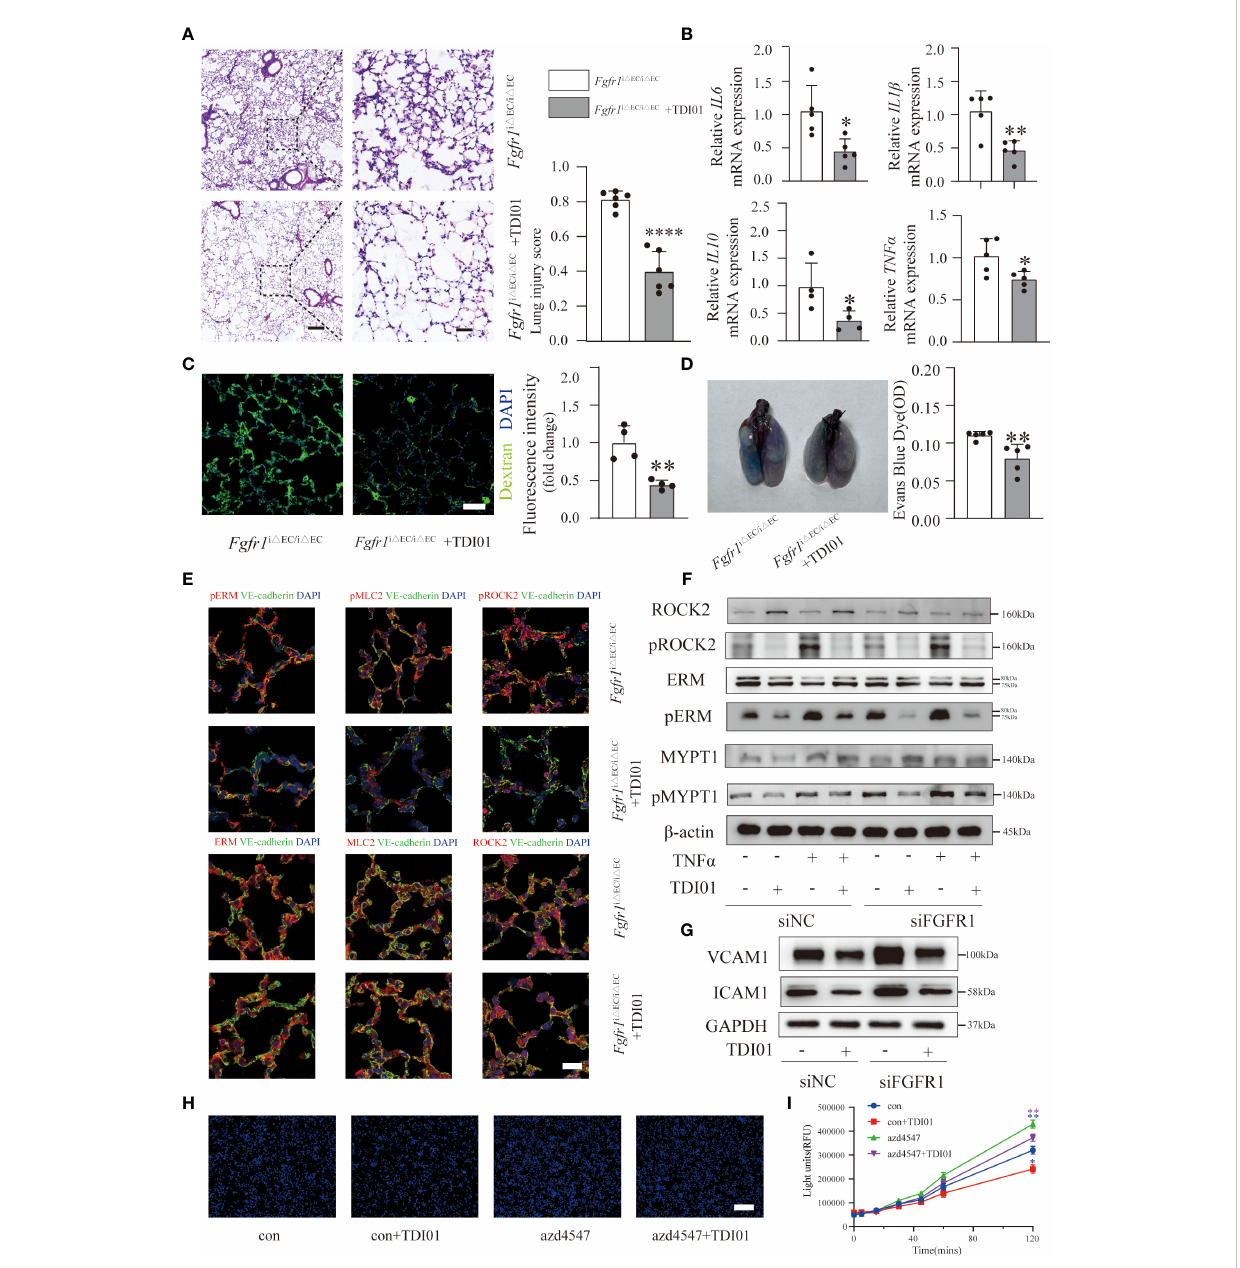
FIGURE 5 TDI01 effectively attenuated ALI/ARDS in Fgfr1 i D EC/i D EC mice and endothelial dysfunction in FGFR1-de fi cient HUVECs. Inhibition of ROCK2 by